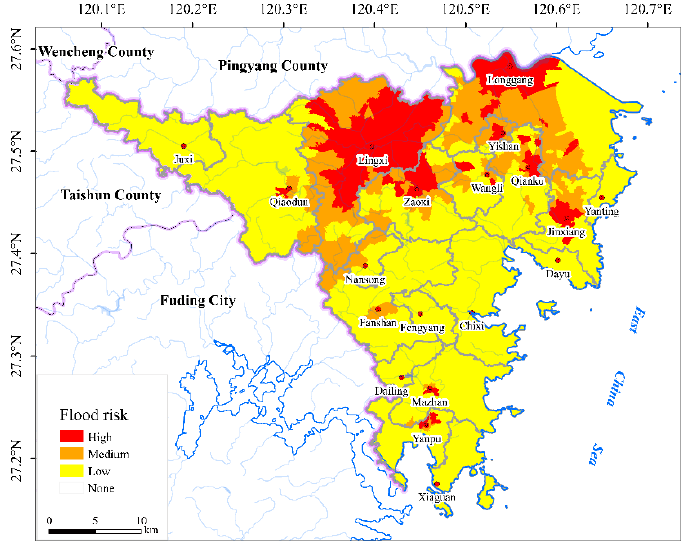
Figure 9. Spatial pattern of comprehensive flood risk in Cangnan County.